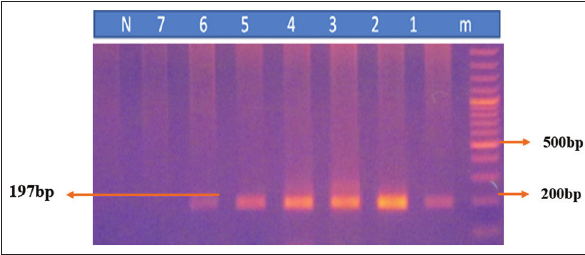
Figure-1: Polymerase chain reaction products amplified using B1 gene. Lane M: 100 bp DNA ladder (Invitrogen), lane N: Negative control, lane 1, 2, 3, 4, 5, and 6: Positive 7 and 8; negative samples. Table-1: Selected primer to amplify a portion of B1 gene for the identification of Toxoplasma gondii . Target gene